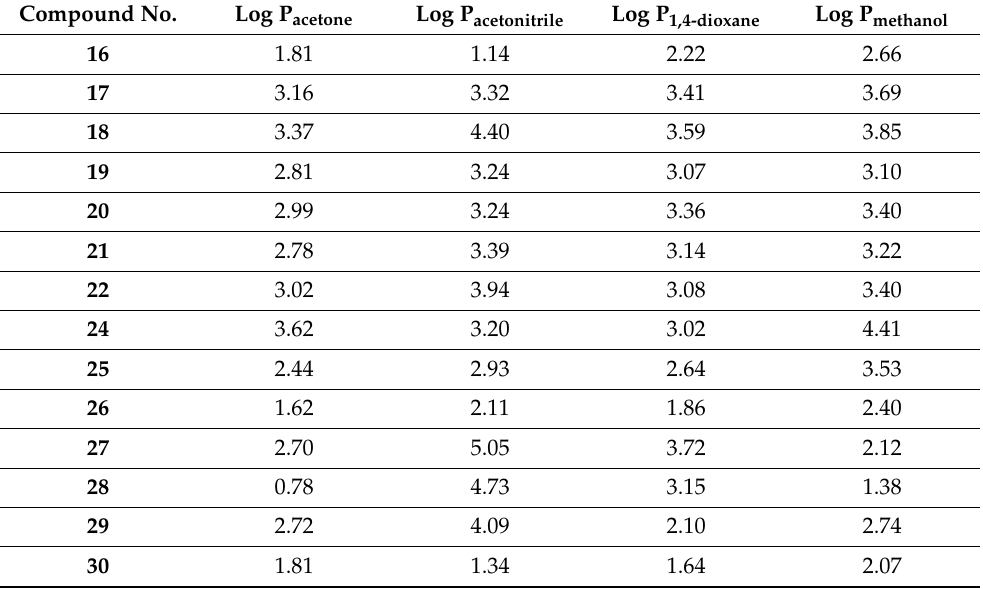
Table 7. The log P EXP values of the synthesized 1,3,4-oxadiazoline derivatives. Compound